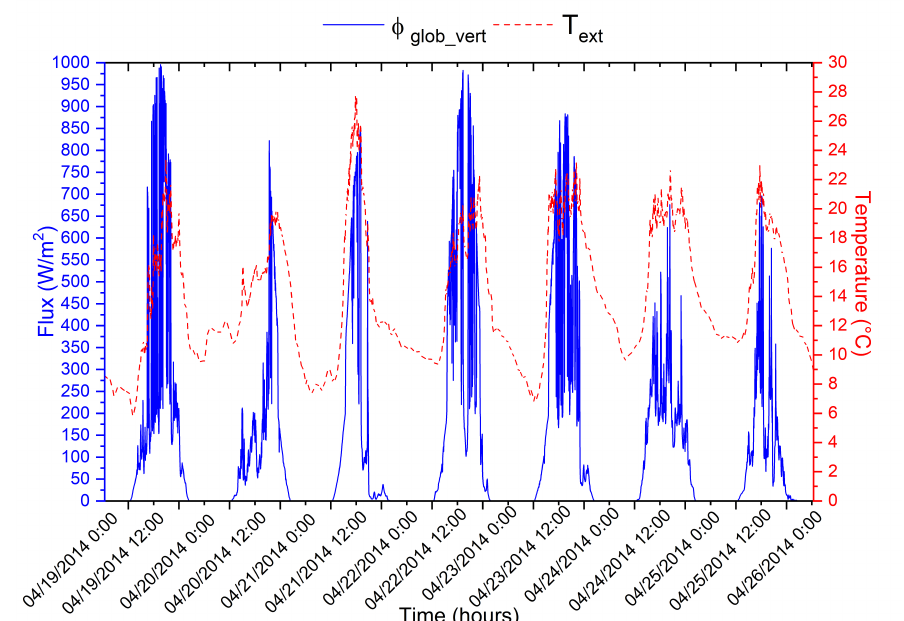
Figure 5. Meteorological data: φ glob_vert denotes global solar radiation on the vertical facade of the wall, and T ext denotes outside air